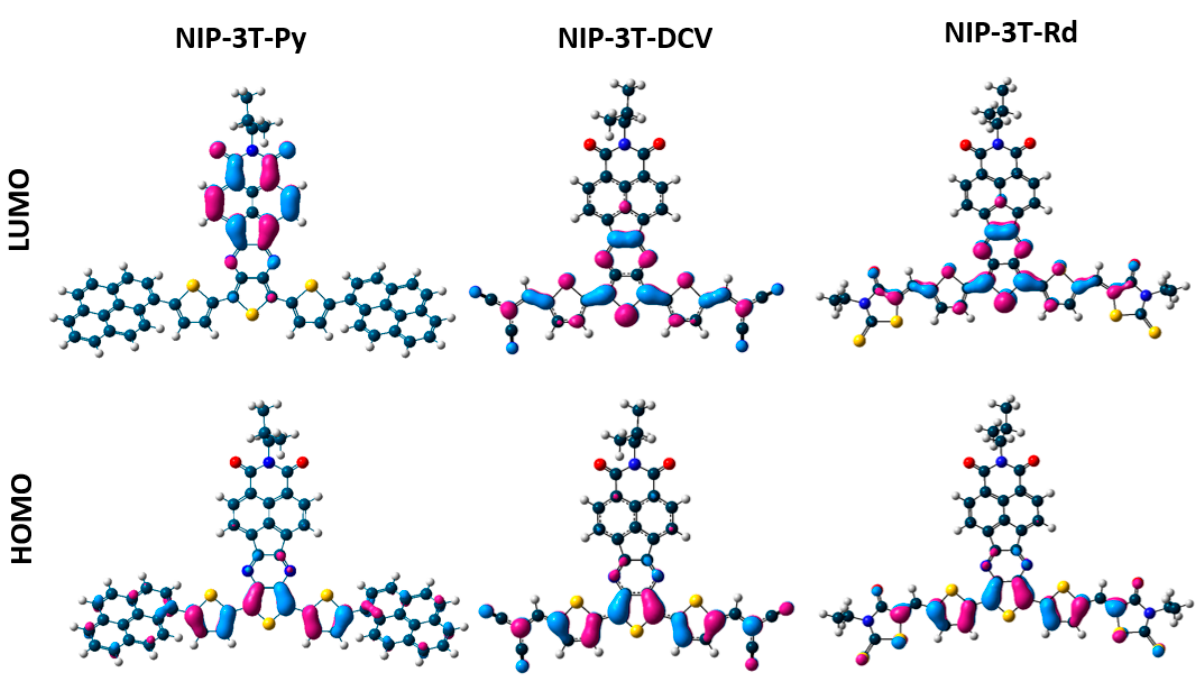
Figure 18. DFT//B3LYP/6-31G** molecular orbital topologies of NIP-3T , NIP-3T-Py , NIP-3T-DCV and NIP-3T-Rd . Adapted from [32] with permission from The Royal Society of Chemistry.